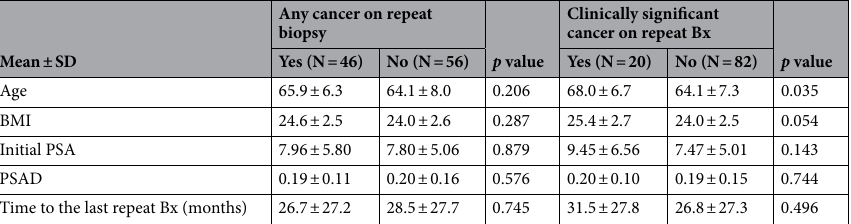
Table 1. Comparative analysis between groups after repeat biopsy. SD standard deviation, BMI body mass index, PSA prostate specific antigen (ng/mL), PSAD prostate specific antigen density (ng/mL/cc), Bx prostate biopsy.